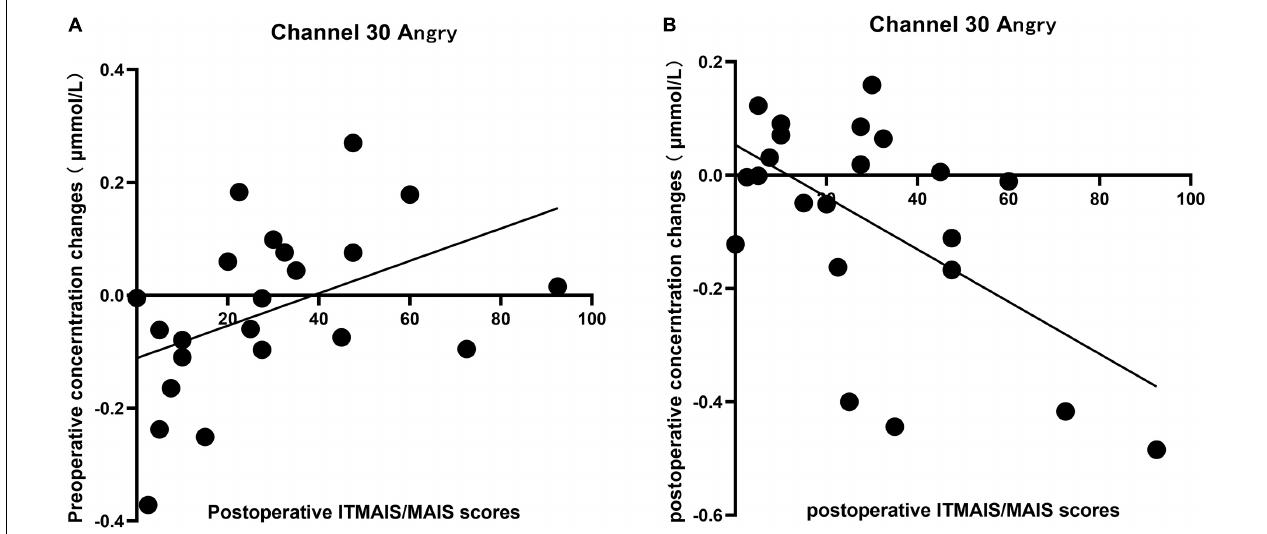
FIGURE 5 | Correlation between the changes in the cortical oxyhemoglobin response to angry vocal emotions in channel 30 (located in the right supramarginal gyrus of Wernicke’s area) and the changes in the IT-MAIS/MAIS score. (A) A positive correlation was observed between preoperative neural responses to postoperative behavioral outcomes (Pearson’s correlation coefficient, r = 0.455, p = 0.033, n = 22). (B) A negative correlation was observed between the postoperative neural responses to postoperative behavioral outcomes (Pearson’s correlation coefficient, r = − 0.576, p = 0.005, n =